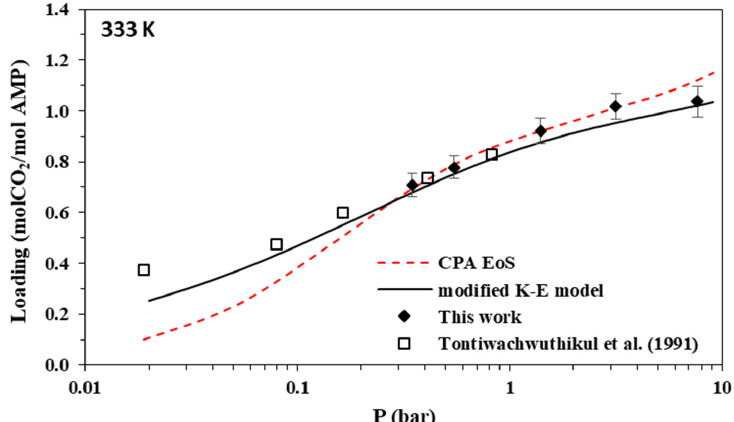
Figure 6. Solubility of CO 2 in aqueous AMP (17.7% wt.) solutions at 333 K. Experimental data (points, from this work and Tontiwachwuthikul et al. [31]) and correlations (lines) with the CPA equation of state and the modified Kent–Eisenberg model.